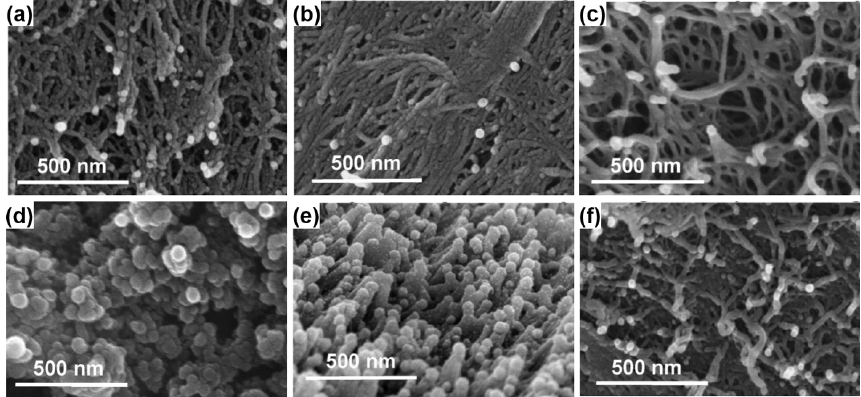
Figure 6. SEM images of PI aerogels synthesized from ( a ) ODA/BPDA; ( b ) PPDA/BPDA; ( c ) DMBZ/BPDA; ( d ) ODA/BTDA; ( e ) DMBZ/BTDA; and ( f ) PPDA/BTDA. Reproduced